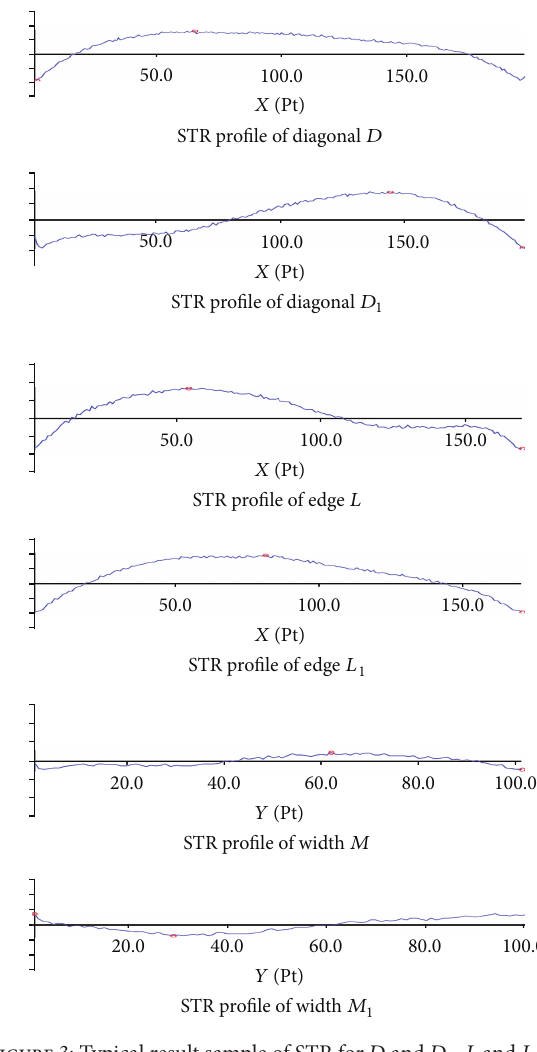
Figure 3: Typical result sample of STR for 𝐷 and 𝐷 1 , 𝐿 and 𝐿 1 , and 𝑀 and 𝑀 1 lines for tile first specimen using new